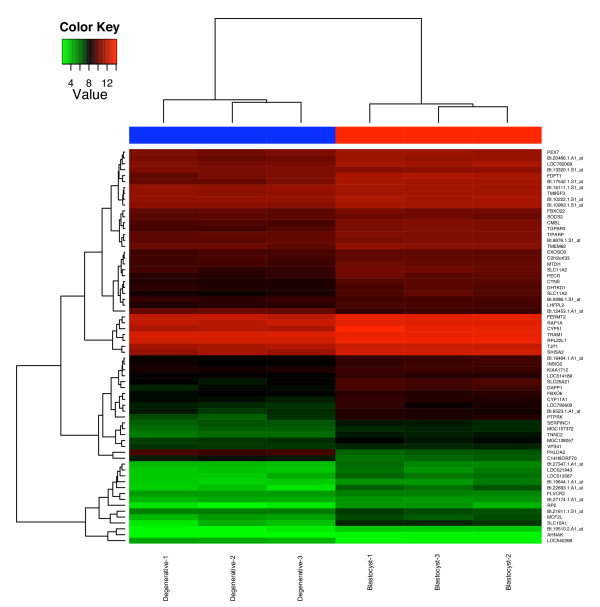
Clustering of expression of candidate genes involved in early embryonic development. Expression levels for 67 differentially expressed genes for the six samples were hierarchically clustered and shown in a heatmap. Level of expression was represented by color scale from green (low) to red (high), as indicated by a scale bar in the upper left corner. Dendrograms of distances were also shown for genes (left) and samples (top). Names of samples and genes were indicated on the bottom and right, respectively. For genes without annotation, probe set IDs were shown.